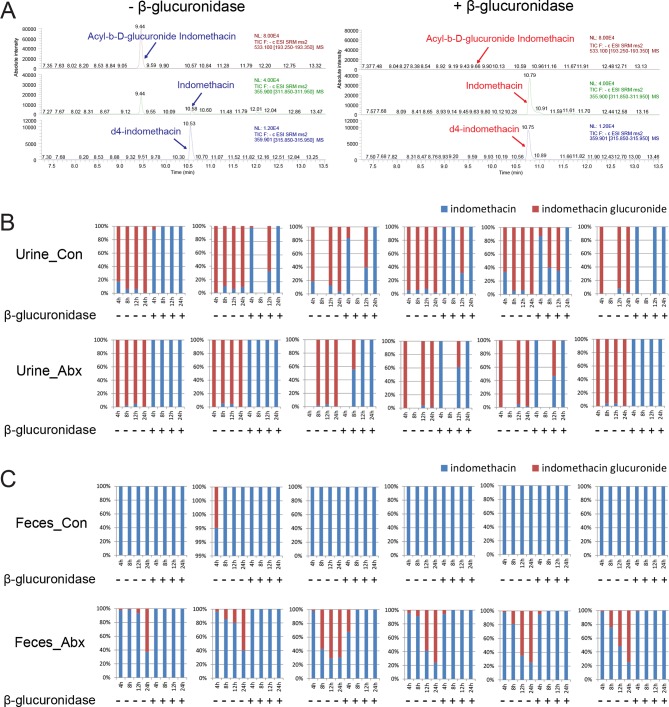
β-glucuronidase catalyzes de-glucuronidation reaction.Mice were administered by gavage 10 mg/kg indomethacin in PEG400 after 5 days of antibiotic treatment. Urine and feces were collected at indicated times for the analysis of glucuronidation by in vitro by incubation with or without β-glucuronidase. (A) Representative spectra of LC/MS measurements of indomethacin and its metabolites. The peak denoting Acyl-b-D-glucuronide Indomethacin (indomethacin glucuronide) is larger without β-glucuronidase (left) than with β-glucuronidase (right). The peak denoting indomethacin is smaller without β-glucuronidase (left) than with β-glucuronidase (right). In urine (B) and feces (C) samples of control (upper) and antibiotic (lower) groups, the proportions of indomethacin glucuronide are smaller with β-glucuronidase added. Similarly, the proportions of indomethacin are larger with β-glucuronidase added. Each graph shows the longitudinal changes in one mouse. N=6/group.